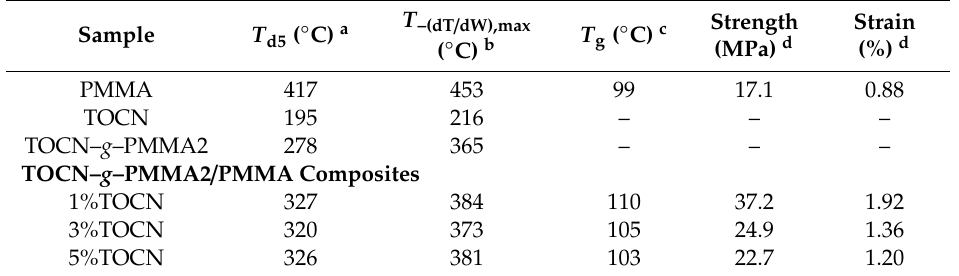
Figure 8. Thermogravimetric analysis (TGA) traces of ( a ) pure PMMA, ( b ) TEMPO-oxidized cellulose nanofibers (TOCN), ( c ) TOCN – g – PMMA2, and ( d – f ) TOCN – g – PMMA2/PMMA composites with different TOCN weight percentage. Thermal properties of TEMPO-oxidized cellulose nanofibers (TOCNs) and PMMA-based